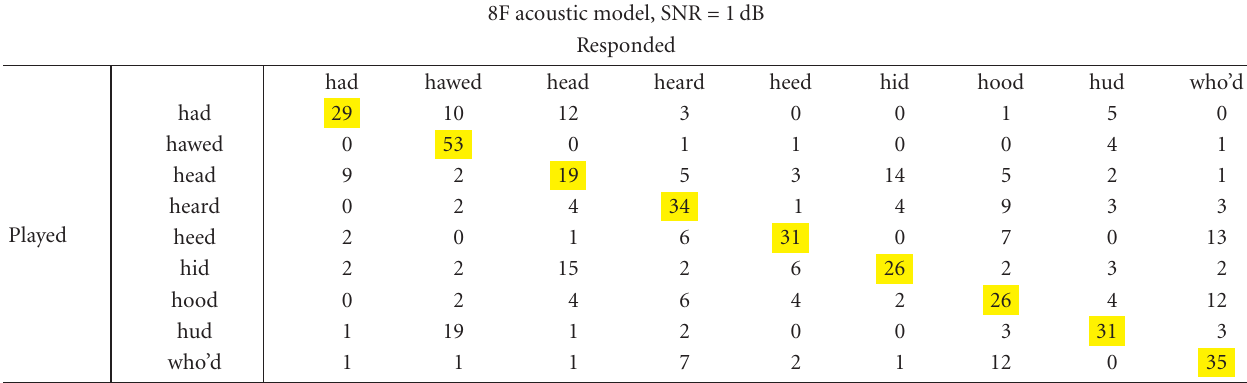
Table 1: Example confusion matrix for 8F vowels at +1dB SNR. Responses are pooled from all test subjects.